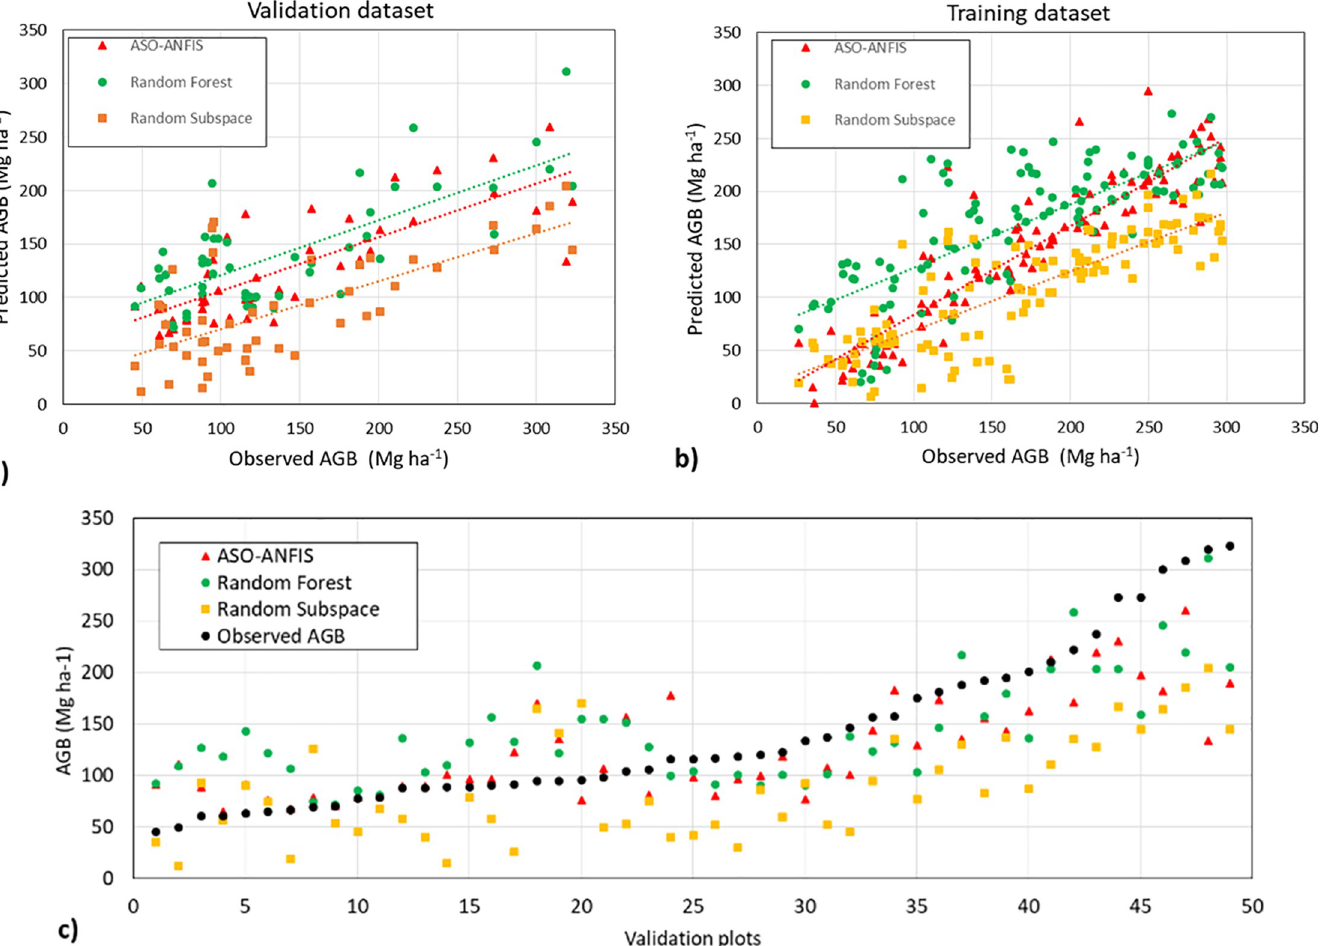
Fig 6. Scatter plots between the predicted AGB and observed AGB by using ten selected features from GA. a) validation dataset, b) training dataset, and c) estimated AGB in ascending order of observed AGB.